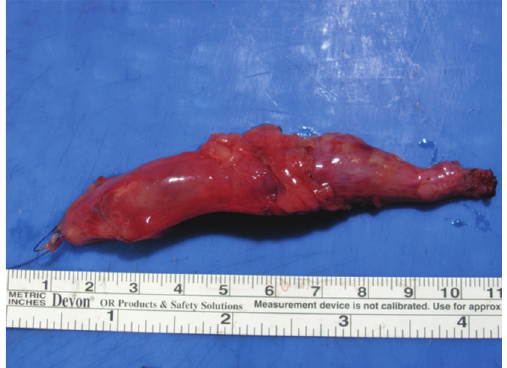
Figure 3: Macroscopic view of the excised ureteral segment.